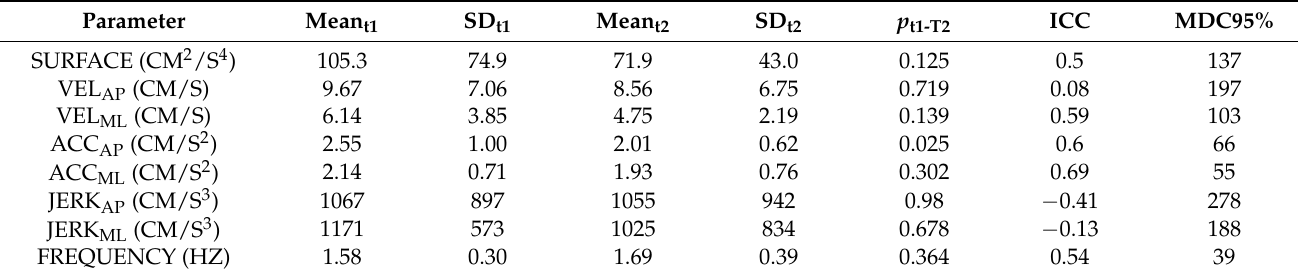
Table 5. Reliability and minimal detectable change: semi-tandem stance soft ground with closed eyes ( n = 9).